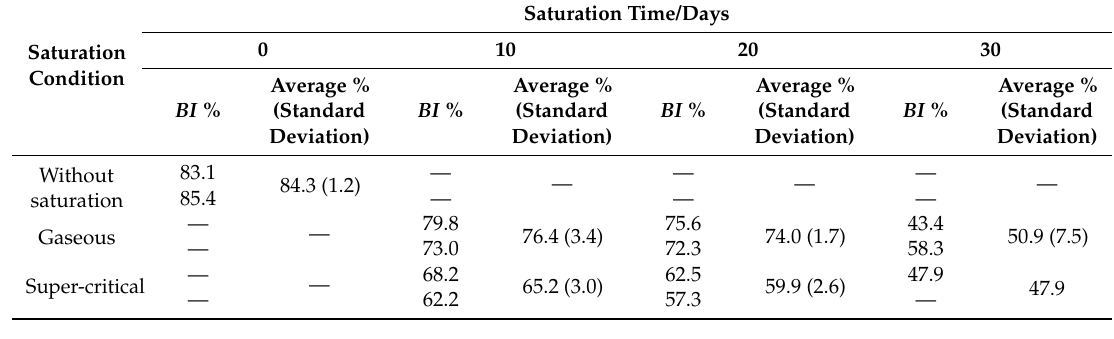
Table 5. Brittleness index for samples with different saturation conditions.